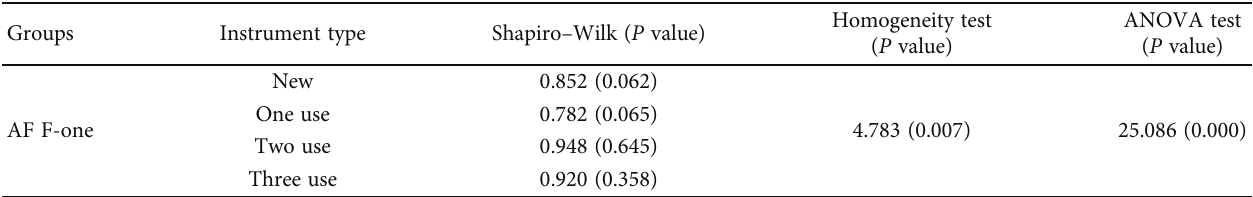
Table 2: Normality, homogeneity, and ANOVA test outcome for instruments in AF F-one group. Groups